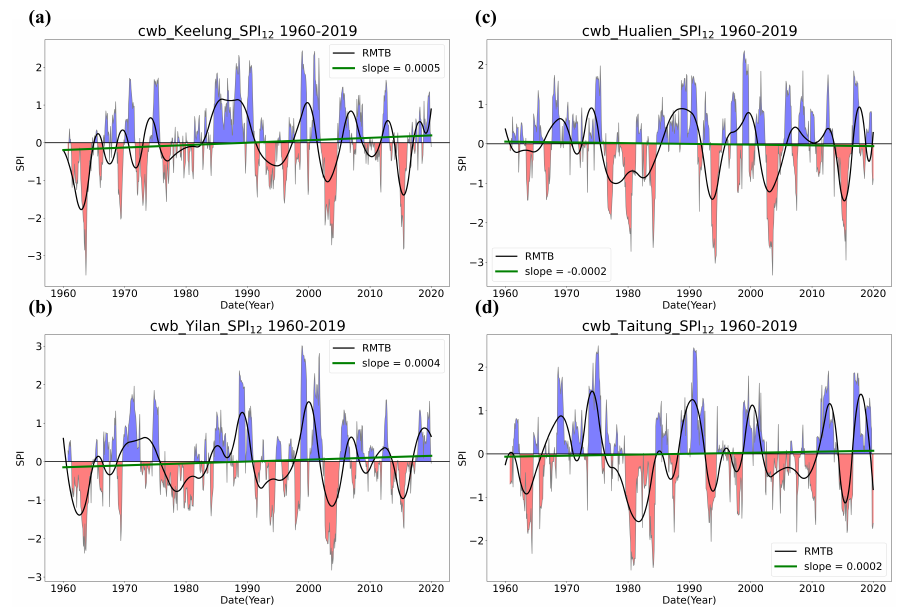
Figure 6. The same as Figure 5, but for four CWB stations over the eastern side of Taiwan.